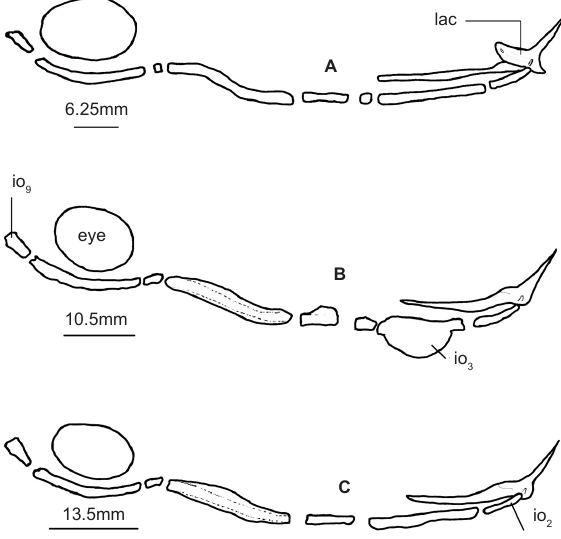
Figure 4. Lateral view of infraorbital series: A - G. chindwinica (MUMF 9997); B - G. ngapang (MUMF 6141); C - G. granulus (MUMF 9991). lac- lacrimal (first infraorbital); io - infraorbital 1-10. n